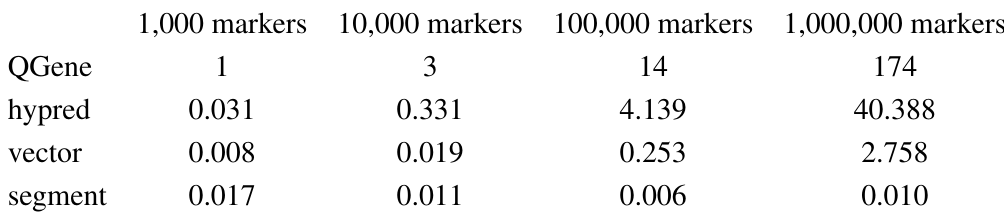
Table 1. Comparison of timing on generating 100 backcrossed progeny ( ( A × B ) × B ). Each entry corresponds to the execution time in seconds. Compared to existing methods QGene and hypred, a greater than ten-fold decrease by segments is shown in blue and a greater than hundred-fold decrease in